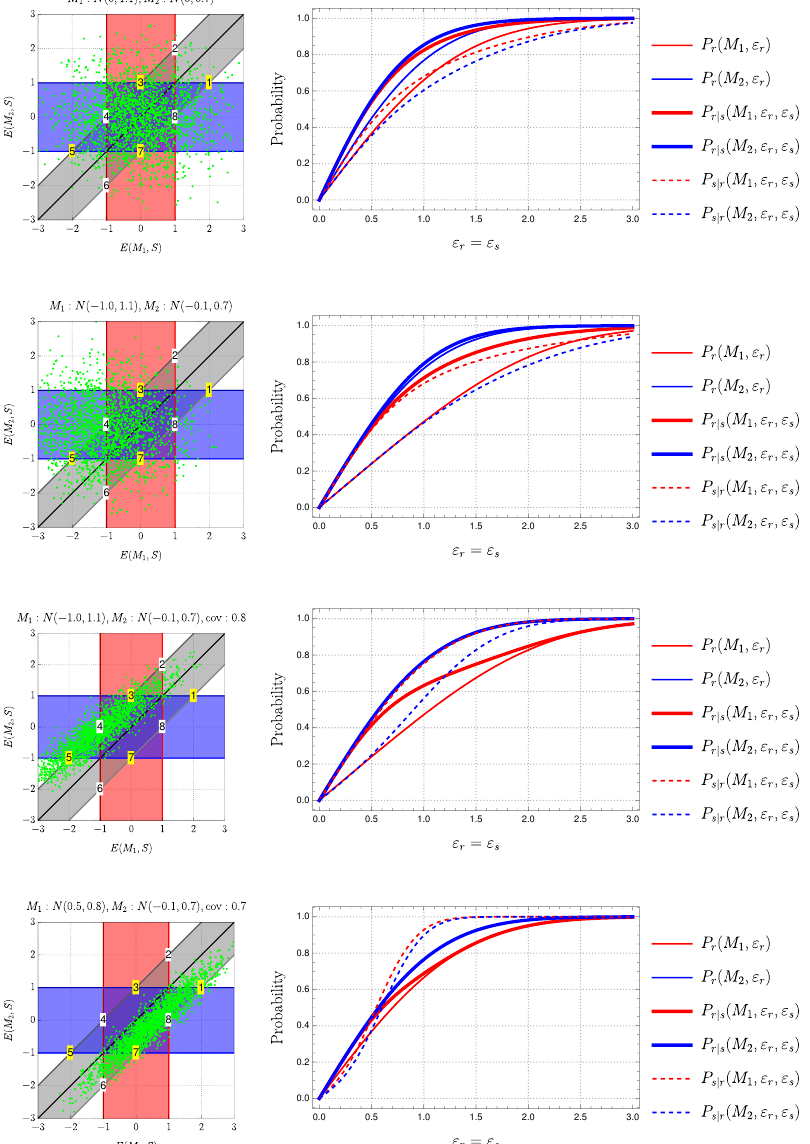
Figure 2. Examples of reliability and similarity configurations ( left ) and the corresponding probabil- ity curves ( right ) for two error sets sampled from normal distributions. See the text for